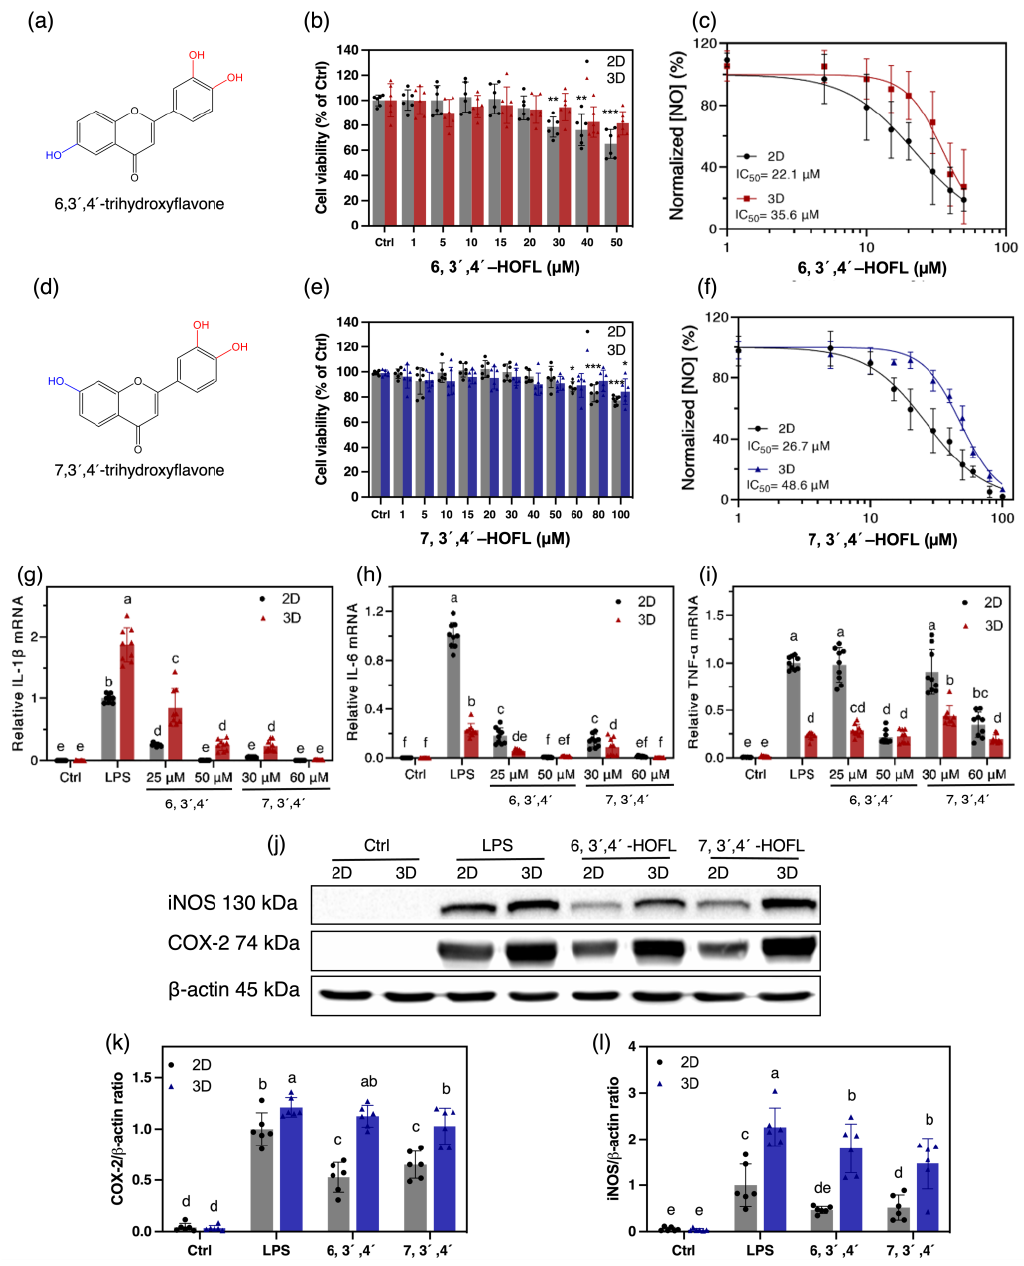
Figure 3. Cytotoxicity and anti-inflammatory activities of 6,3’,4’- and 7,3’,4’-HOFL on 100 ng/mL LPS-induced 2D and 3D RAW264.7 cells. Chemical structures ( a , d ); cytotoxicity ( b , e ); and dose – response curves of NO suppression ( c , f ); n = 6. The inhibitory activity on the gene expressions of IL-1 β ( g ), IL-6 ( h ), and TNF- α ( i ) on 2D and 3D cells; n = 9. Inhibitory activities of 6,3’,4’- (50 µ M) and 7,3’,4’-HOFL (60 µ M) on the protein expressions of iNOS ( k ), COX-2 ( l ), and their bands ( j ); n = 6. The data are shown as mean ± SD. * p < 0.05, ** p < 0.01, *** p < 0.001, and lowercase letters represent the differences between the sample groups ( p < 0.05).